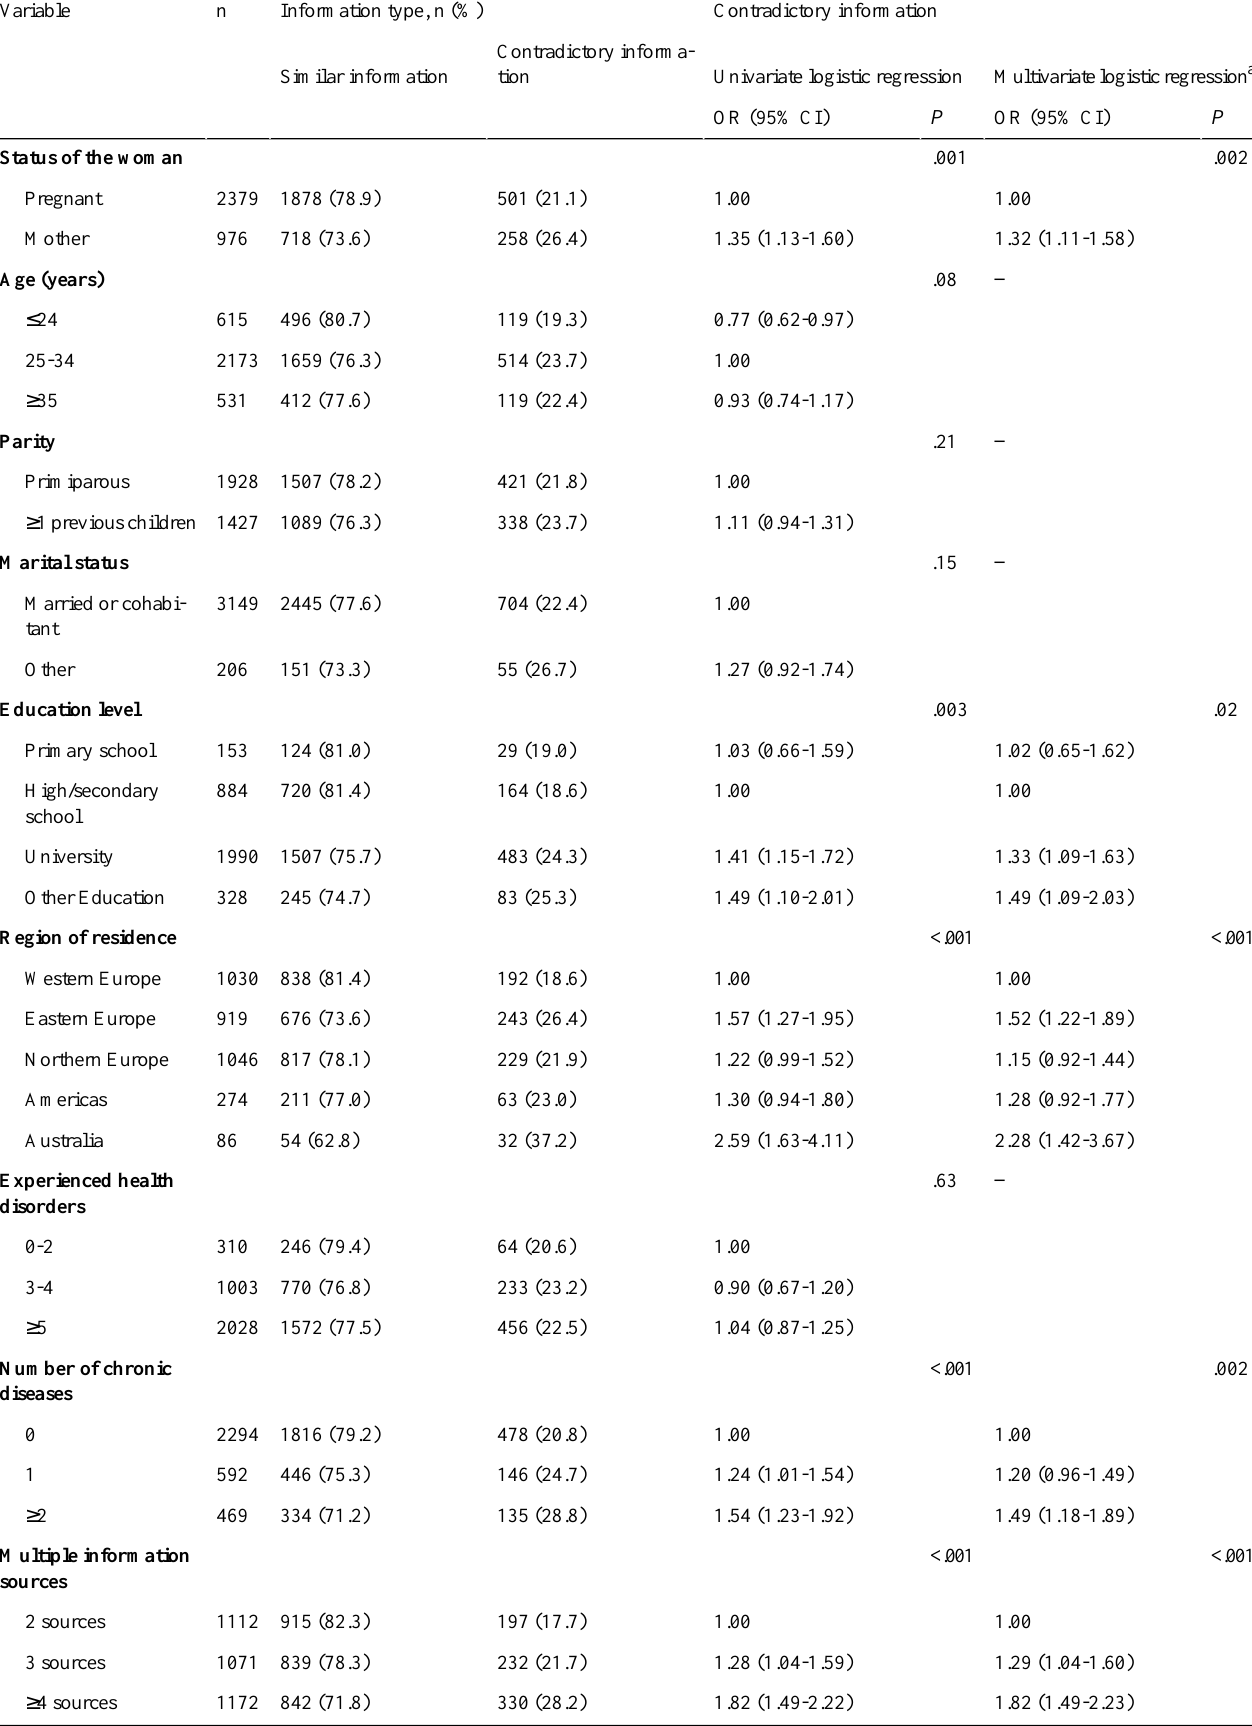
Table 1. Univariate and multivariate analysis of factors associated with conflict of information (n=3355).